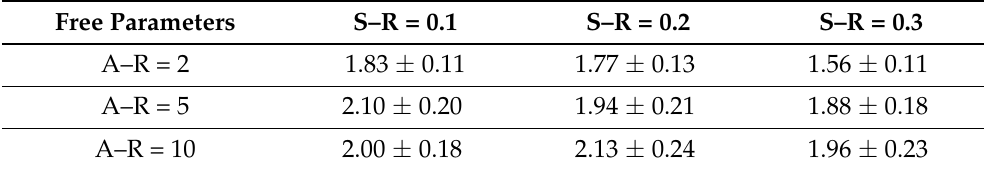
Table 4. Ratio between total number of multiplets in original 100,000 years simulated catalogs and average of respective randomized catalogs.